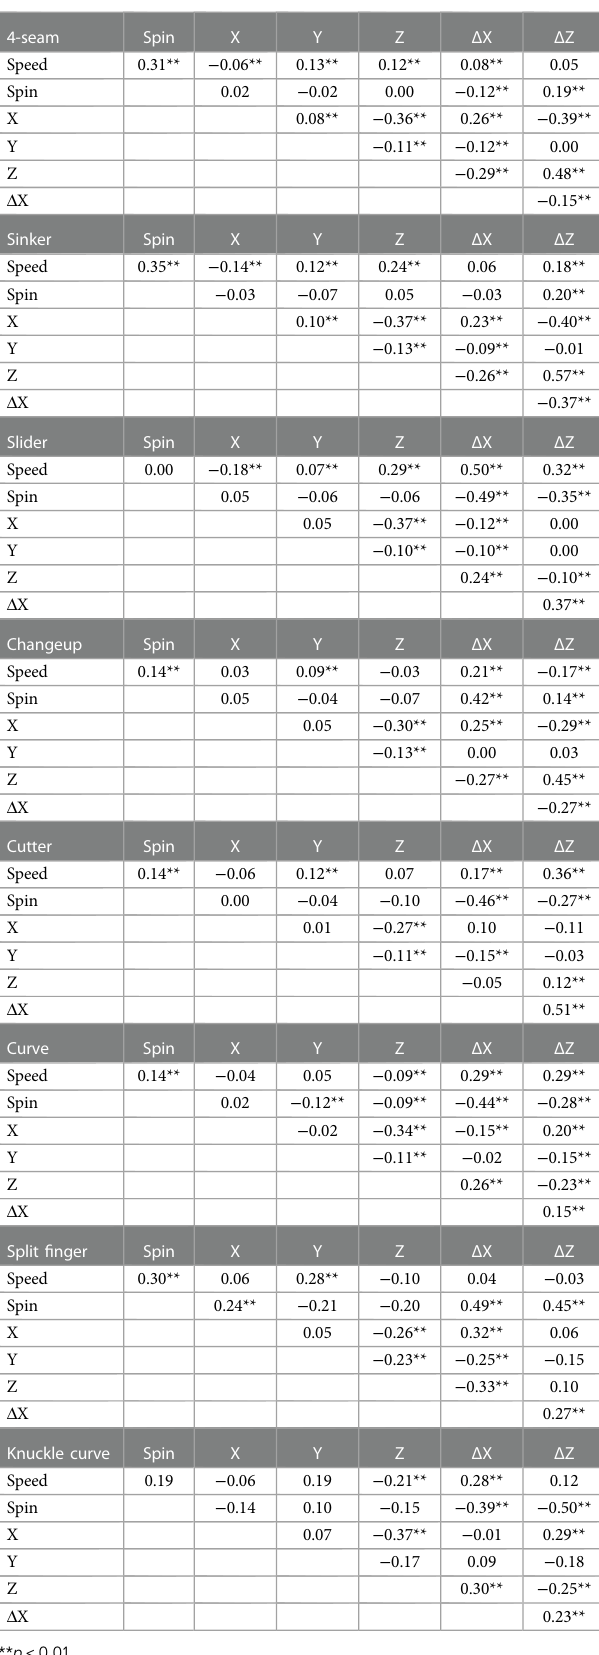
TABLE 4 The r value of correlation coef fi cient among release speed, release point 3D coordinates (X, Y, and Z axes), spin rate, and amount of change ( Δ X and Δ Z) for pitch